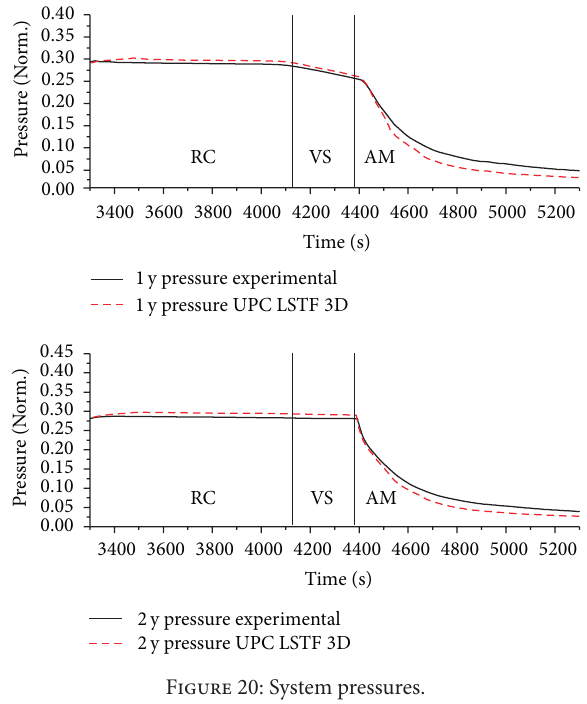
Figure 20: System pressures.